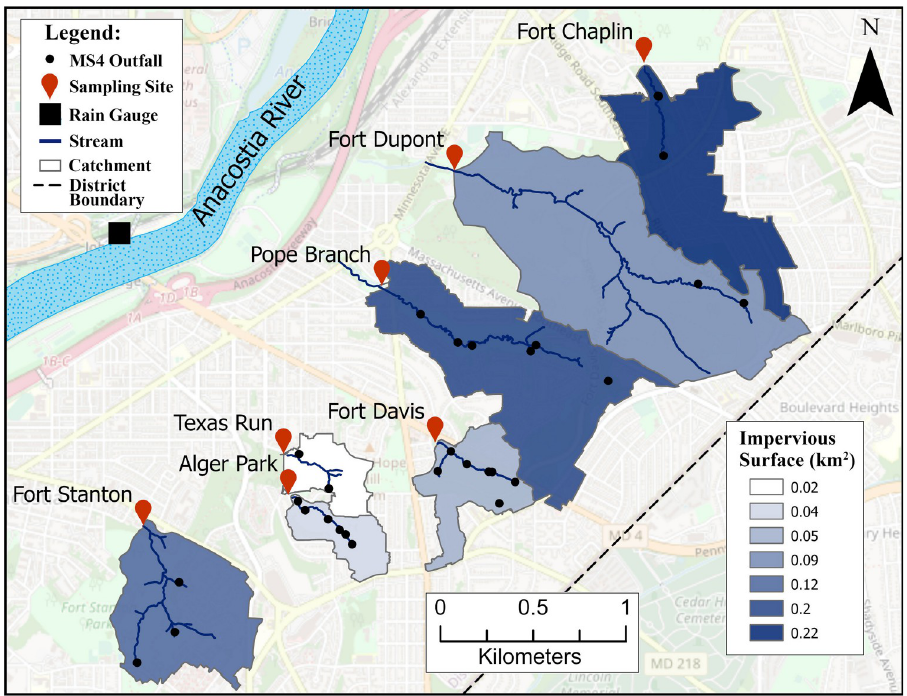
Fig 1. Geographic information system (GIS) map showing size and location of seven catchments included in study. Sampling locations are denoted with a red symbol. The rain gauge is indicated by a black shaded square. Catchments are colored based on total impervious surface area (km 2 ). See legend for stream and catchment boundary information. The underlaying street map is from OpenStreetMap (Data available under the Open Database License: https://www.openstreetmap.org/copyright).